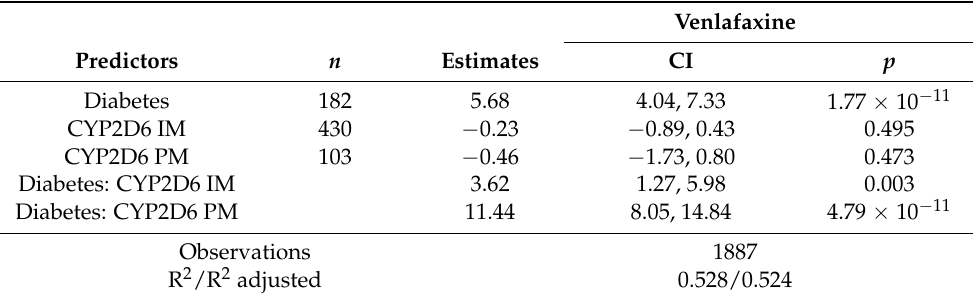
Table 5. Association between CYP2D6 metabolic phenotype and HbA1c levels among participants taking venlafaxine. Model adjusted by age, ethnicity, sex, taking inhibitors of CYP2D6, diabetes status, taking anti-diabetics and BMI; Normal metabolizers of CYP2D6: 1352.